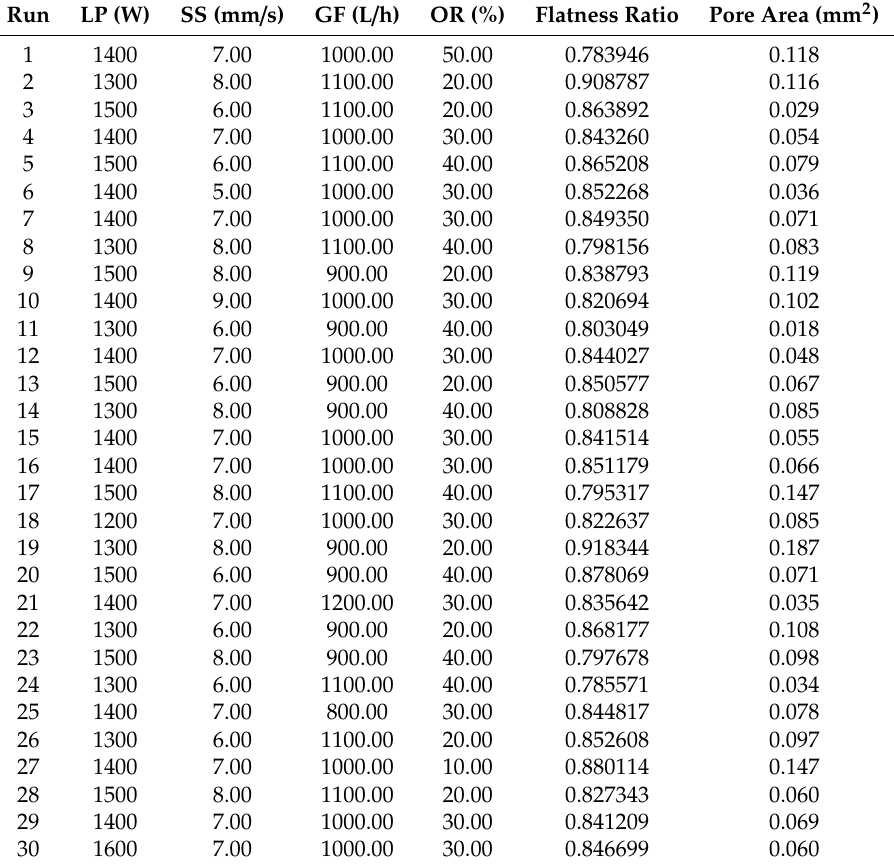
Table 3. Central composite design of input variables and the corresponding